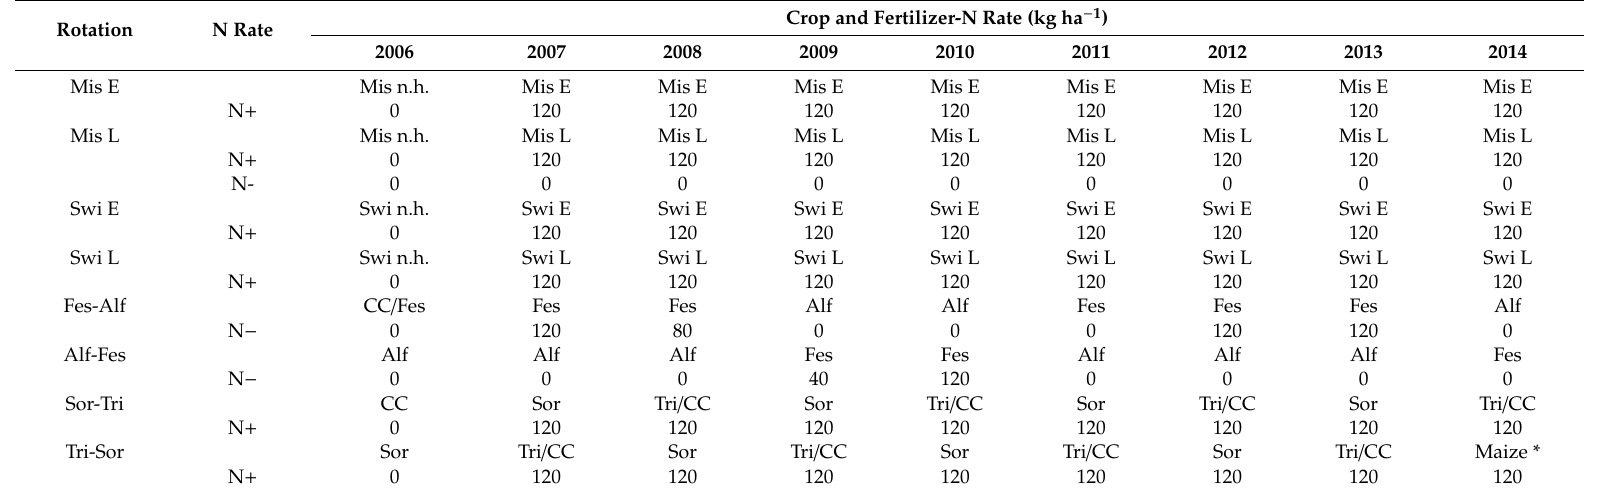
Table 1. Treatments of the B&E long-term experiment (combining rotation and fertilizer-N rate) included in the study (Mis, miscanthus; Swi, switchgrass; Fes, fescue; Alf, alfalfa; Sor, fiber sorghum; Tri, triticale; CC, catch crop; E, early harvest (October); L, late harvest (February); N − , low fertilizer rate; N + , high fertilizer rate; n.h., not